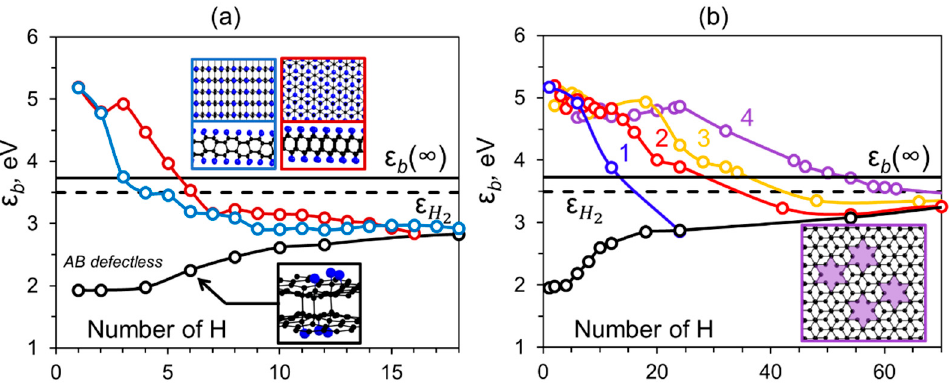
Figure 1. ( a ) Average binding energy ε b ( n ) as a function of numbers of atoms in H cluster for bilayer graphene contained a vacancy in one layer with AB (red line) and AA’ (blue line) stacking. In the inset, the top and side views of atomic structures of infinite cubic and hexagonal diamane are presented framed by the corresponding color. Also the initial stage of diamane nucleation in perfect AB stacked graphene is presented (framed by black). ( b ) Average binding energy as a function of numbers of atoms in H cluster for AB bilayer graphene contained 1 (blue line), 2 (red line), 3 (yellow line), and 4 (purple line) cross layer vacancies. In the inset top view of graphene with 4 vacancies agglomerate is presented framed by the corresponding color. H bonding energies in the H 2 molecule ( ε H ) and in infinite diamane ( ε b ( ∞ )) are marked by dashed and solid horizontal lines, respectively. The ε b ( n ) dependence for hydrogen on the surface of defectless AB bilayer graphene is shown by black.